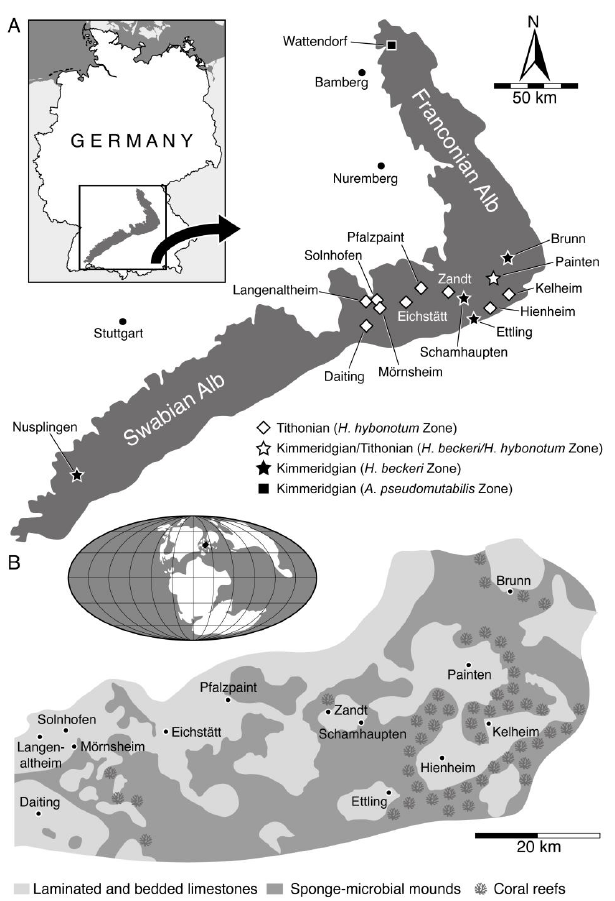
Figure 1. ( A ) Geographic and ( B ) palaeogeographic location maps (modified from [34,72]; biostrat- igraphic information based on [44,73]). graphic information based on